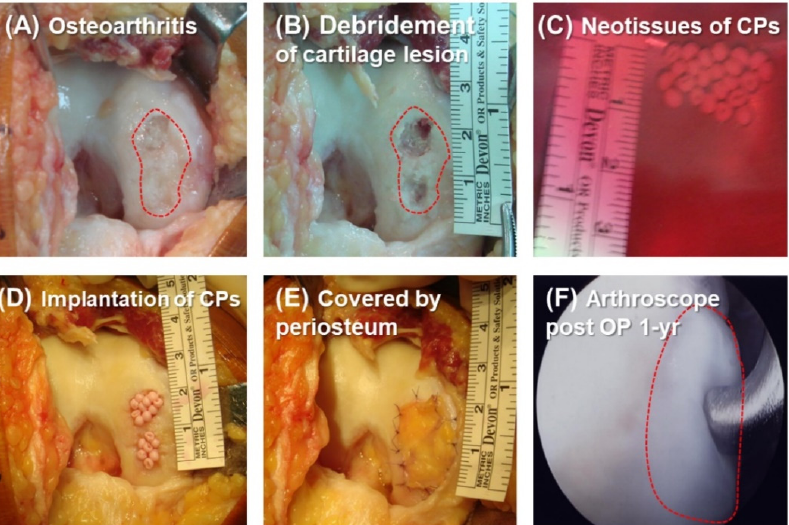
Figure 2. Procedure of the implantation of neotissues of CPs. ( A ) Mid-vastus arthrotomy was performed to reach the knee cartilage lesion where the damaged cartilage was debrided by abrasion arthroplasty ( B ). ( C )The neotissues of CPs were implanted into the defects ( D ) and covered by periosteum ( E ) acquired from the proximal tibia. ( F ) Seven cases received arthroscope examinations to assess the recovery of their cartilage at least one year after the CPs were implanted.